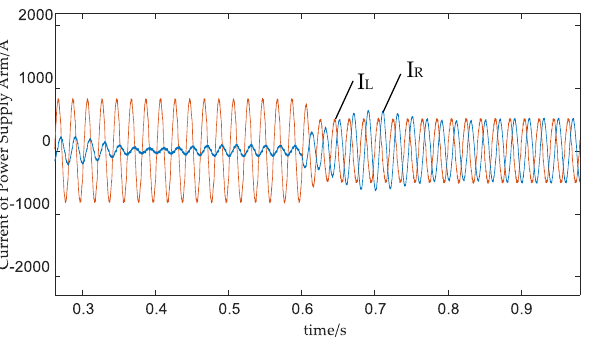
Figure 16. Primary side current waveforms before and after the VSG control was adopted.